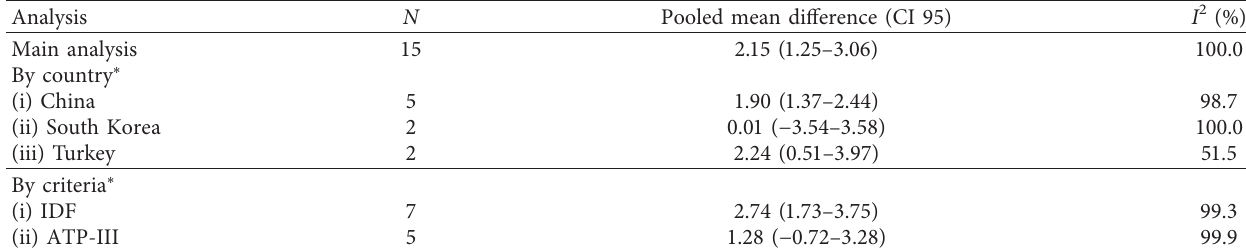
Table 3: Main meta-analysis and subgroup analyses of mean